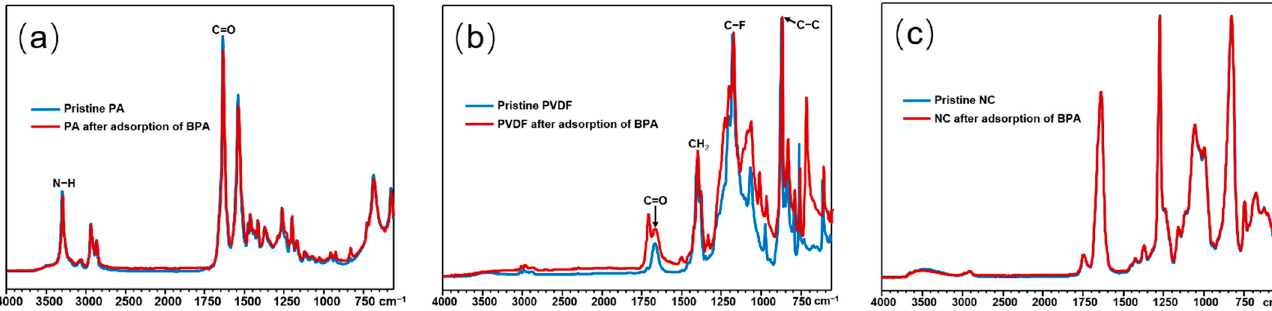
Figure 8. FTIR spectrum of the PA MFMs ( a ), PVDF MFMs ( b ), and NC MFMs ( c